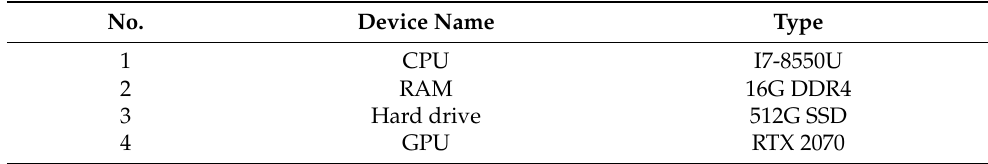
Figure 7. Pictures of production line equipment and sensors. Table 4. The IPC configuration for Res-LSTM model inference. Table 4. The IPC configuration for Res-LSTM model inference.